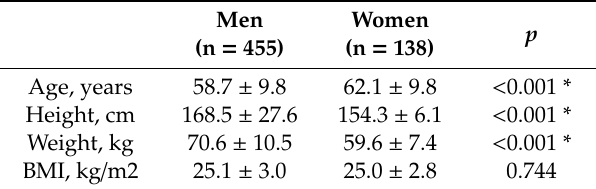
Table 1. Characteristics of participants.